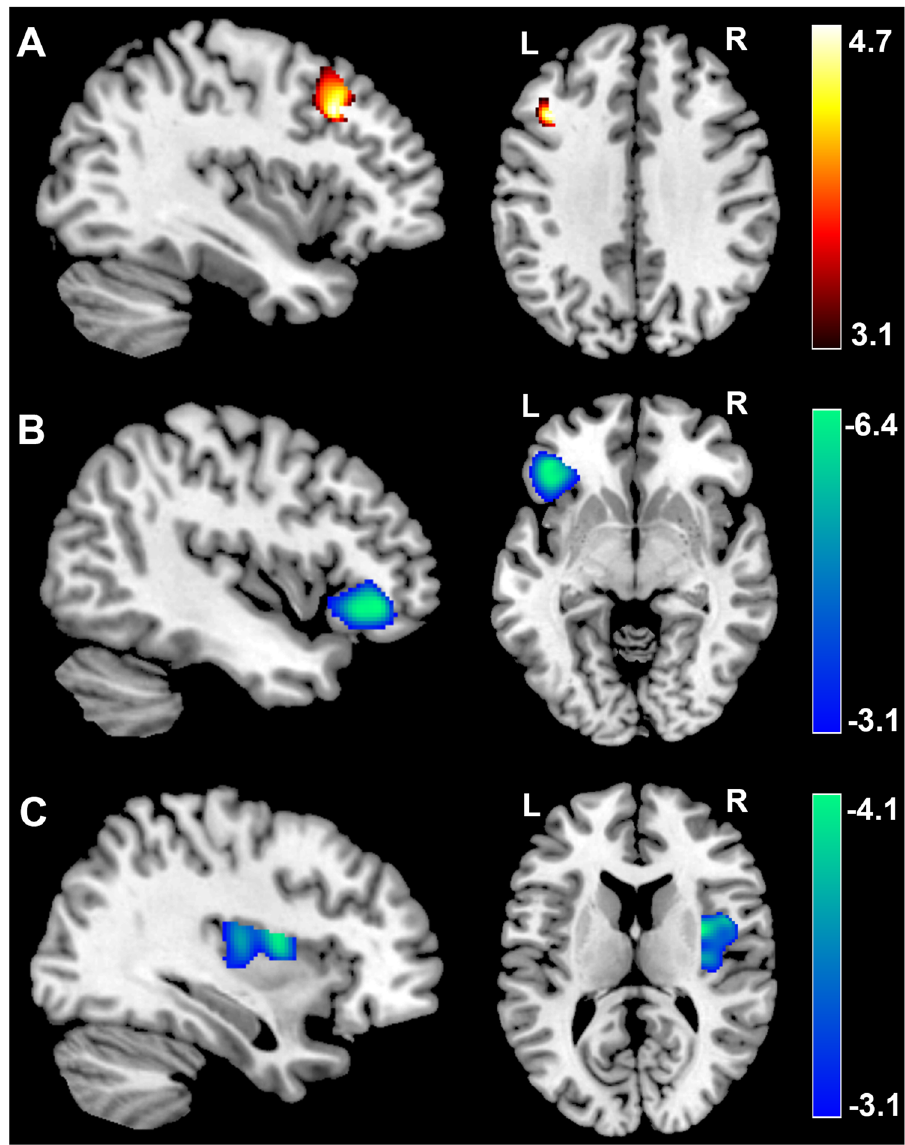
Figure 1. Association between TTF scores and GMV. GMV of the dorsolateral prefrontal cortex were positively correlated with TTF scores ( A ). GMV in the left IFG had a significant, negative correlation with TTF scores ( B ). GMV in the right insular cortex had a significant, negative correlation with TTF scores ( C ). Results are shown at p < 0.05, corrected for multiple comparisons at the cluster-level with non-stationary correction and an underlying voxel level of P < 0.001, uncorrected. The color density represents the T score. TTF: tendency to forgive; GMV: gray matter volume; IFG, inferior frontal gyrus; L, left; R,